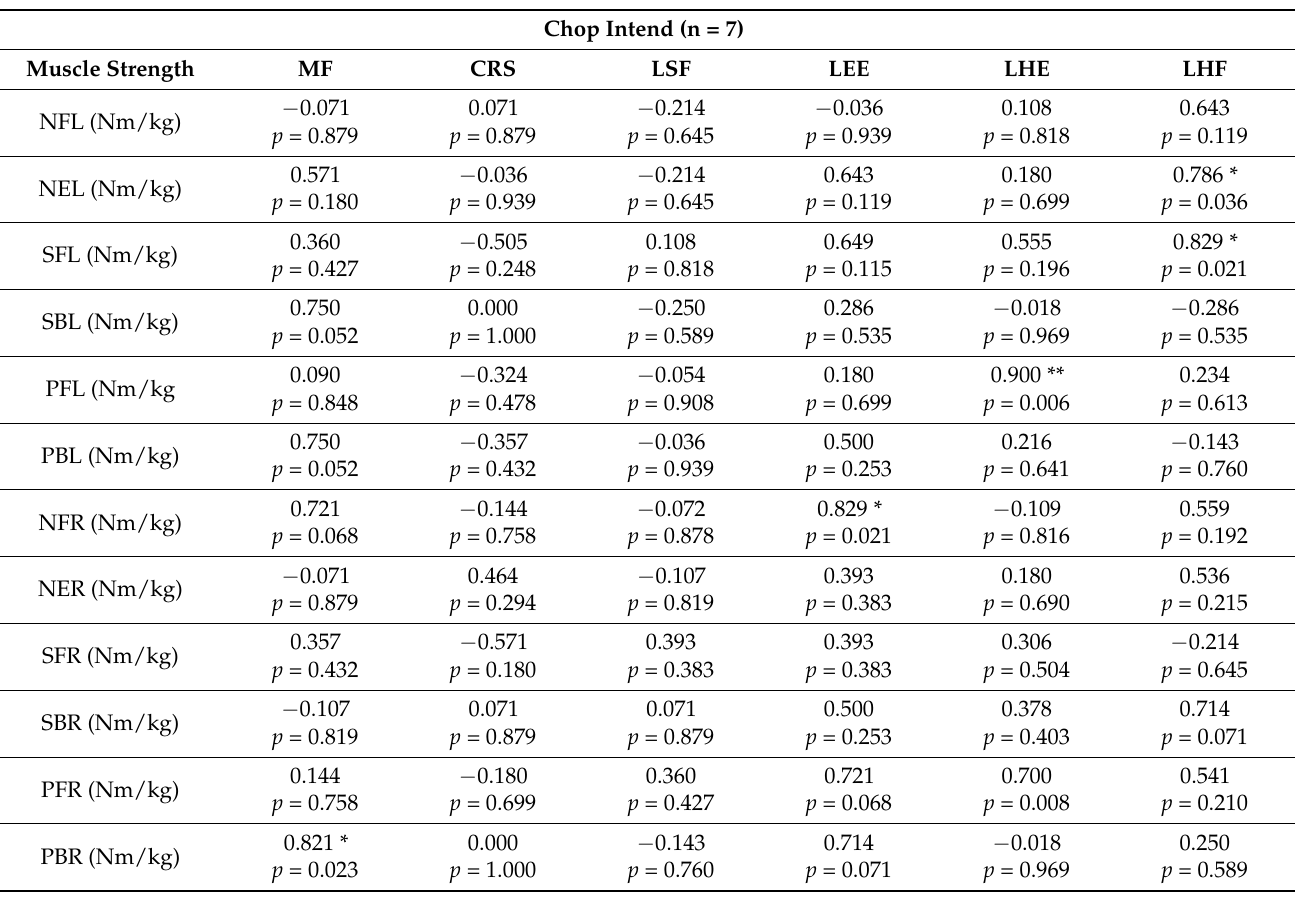
Table 3. Relationships between individual values of muscle strength, MF score, and ROM in the CHOP and HFMS groups. Chop Intend (n = 7) Muscle Strength MF CRS LSF LEE